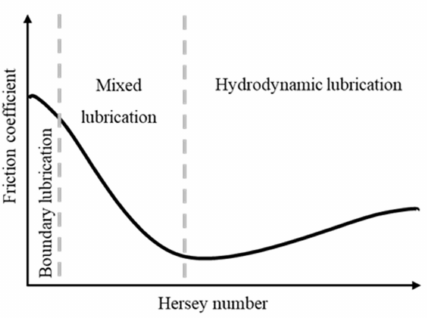
Figure 1. Classification of lubrication regimes of fluid film journal